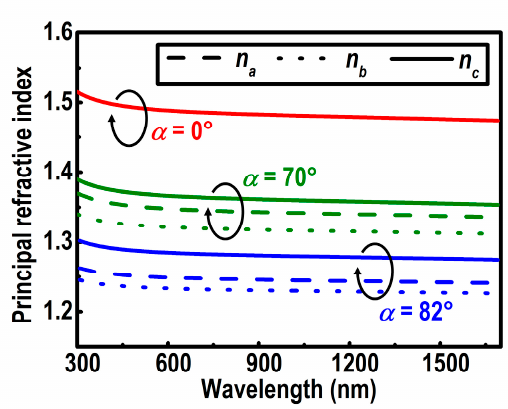
Figure 5. Principal refractive indices n a (dashed lines), n b (dotted lines), and n c (solid lines) of the biaxial YF 3 columnar thin films (CTFs) at deposition angles of 0°, 70°, and 82°, respectively.